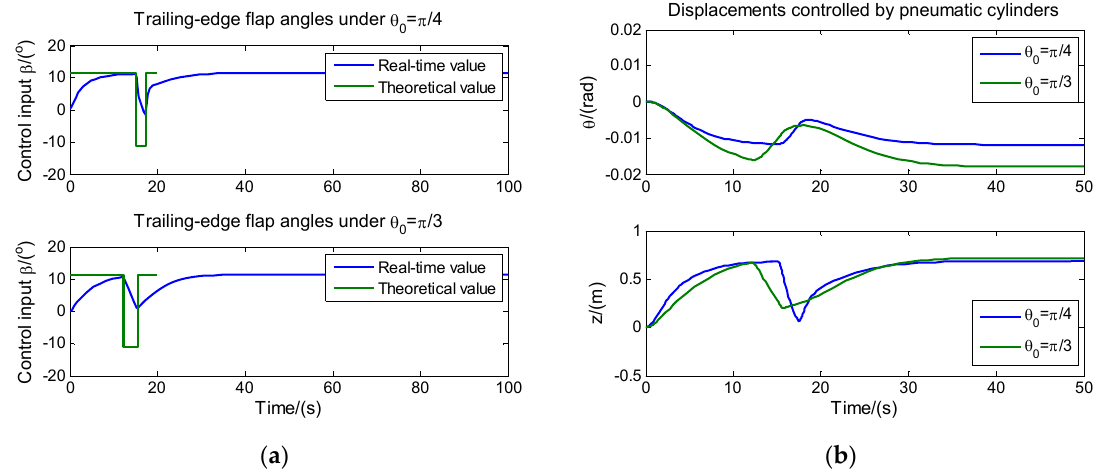
Figure 6. The real-time tracking of trailing-edge flap angles and the real-time displacements controlled by pneumatic cylinders using optimal proportional–integral–derivative (OPID) theory: ( a ) The real-time tracking of trailing-edge flap angles; ( b ) The real-time displacements controlled by pneumatic cylinders.